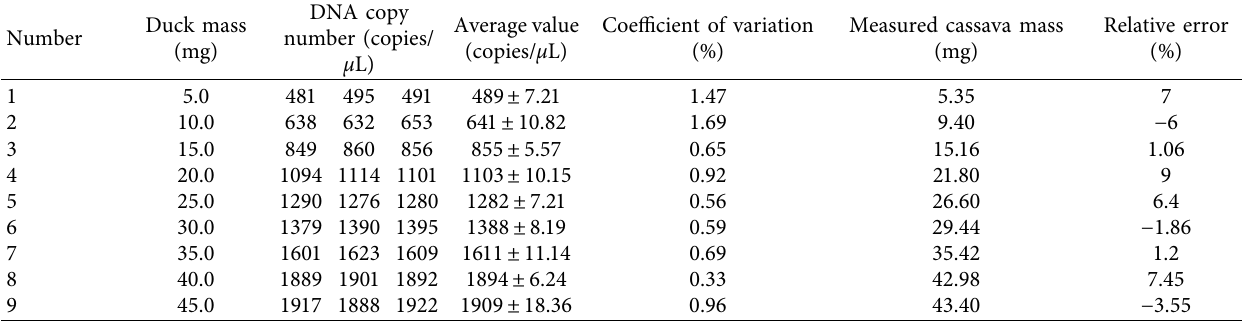
Table 3: Detection by digital PCR of mixed samples with known adulteration